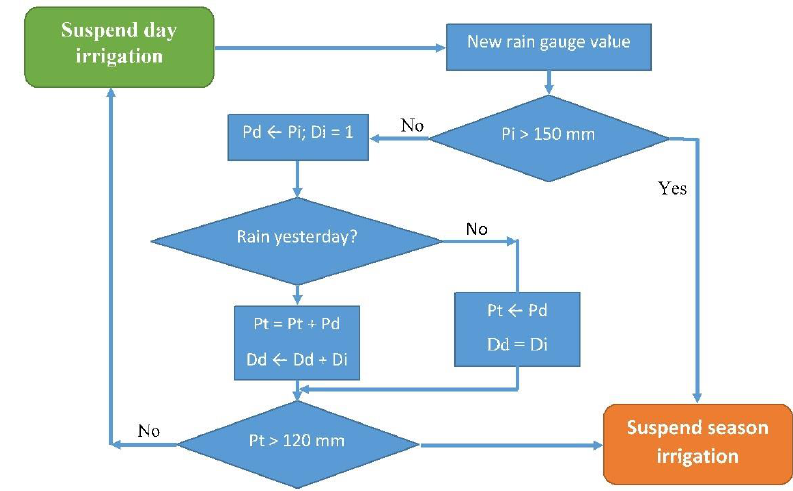
Figure 9. Flow diagram of rainfall sampling and processing.